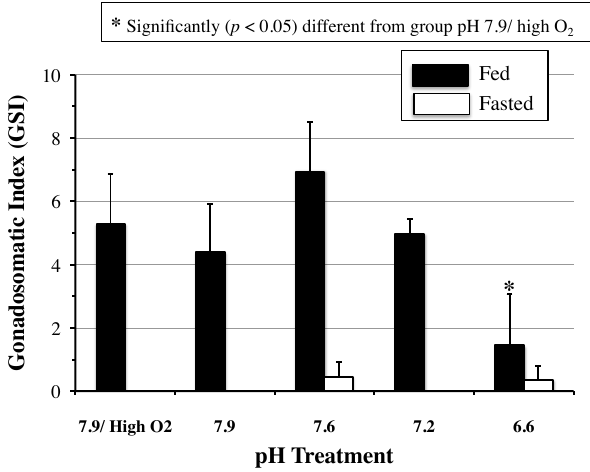
Fig. 6. S. fragilis Gonadosomatic Index (GSI) after 140days of ex- Figure 6. S. fragilis Gonadosomatic Index (GSI) after 140 days of exposure to extreme (pH 2 posure to extreme (pH 6.6), high (pH 7.2), moderate (pH 7.6) and 6.6), high (pH 7.2), moderate (pH 7.6) and control (pH 7.9) p CO 2 at in situ O 2 levels, and to 3 control (pH 7.9) p CO 2 at in situ O 2 levels, and to control p CO 2 (pH control p CO 2 (pH 7.9) at 100% air saturation, following feeding and fasting regimes. GSI is 4 7.9) at 100% air saturation, following feeding and fasting regimes. shown as mean ± SEM. 5 GSI is shown as mean ±